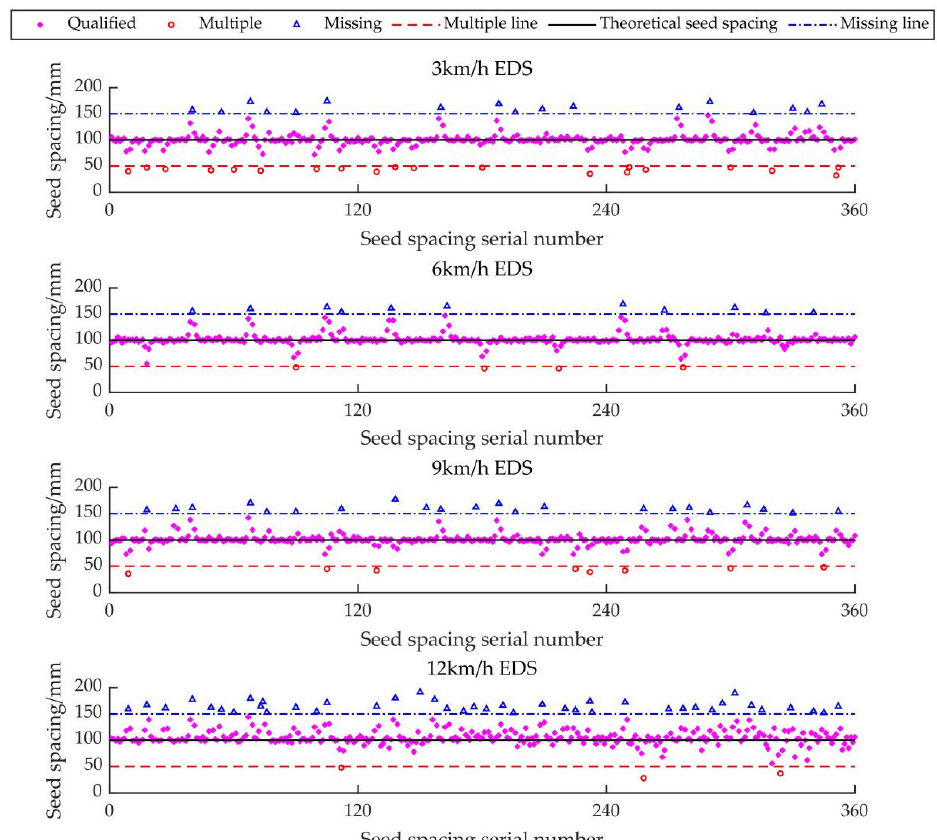
Figure 12. The distance distribution of intelligent EDS under each index.